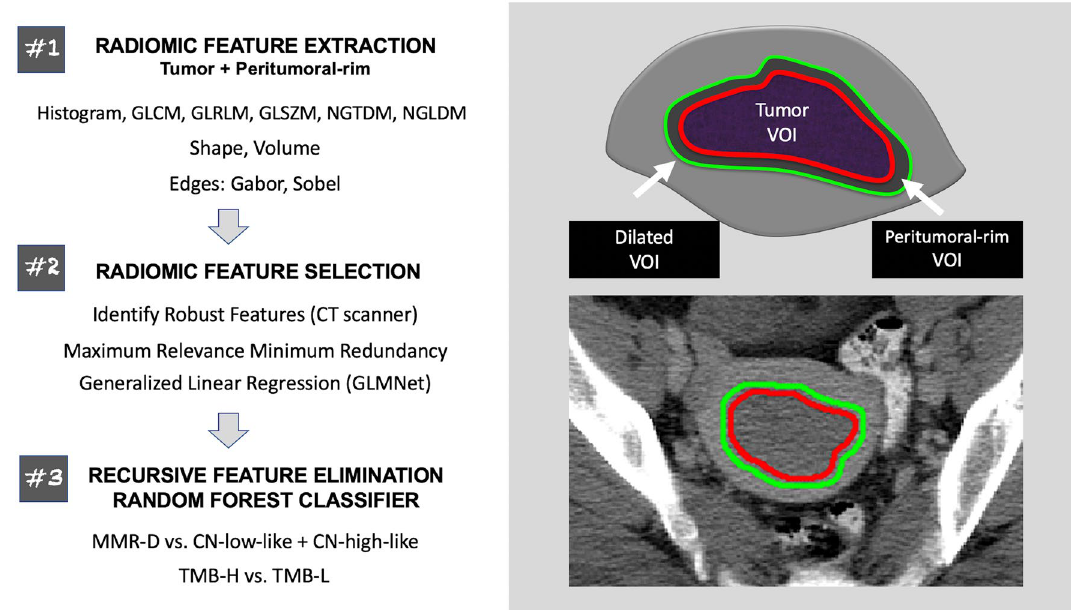
Figure 1. Schematic overview of the methods employed in this study. The radiologist-defined tumor VOIs were used to extract intra-tumoral radiomic features. Peritumoral-rim was generated by automatically expanding the tumor contours by 3 mm and subtracting the dilated VOI from the tumor VOI. Peritumoral-rim features were computed as the differences in the values of radiomic features between the dilated VOI and the tumor VOI. The features are later down-selected via a multi-step approach; the selected features were z-score standardized and used to construct the classifiers. CT computed tomography, GLCM gray level co-occurrence matrix, GLRLM gray level run length matrix, GLSZM gray level size zone matrix, NGTDM neighborhood gray tone difference matrix, NGLDM neighborhood gray level dependence matrix, MMR-D DNA mismatch repair-deficient,